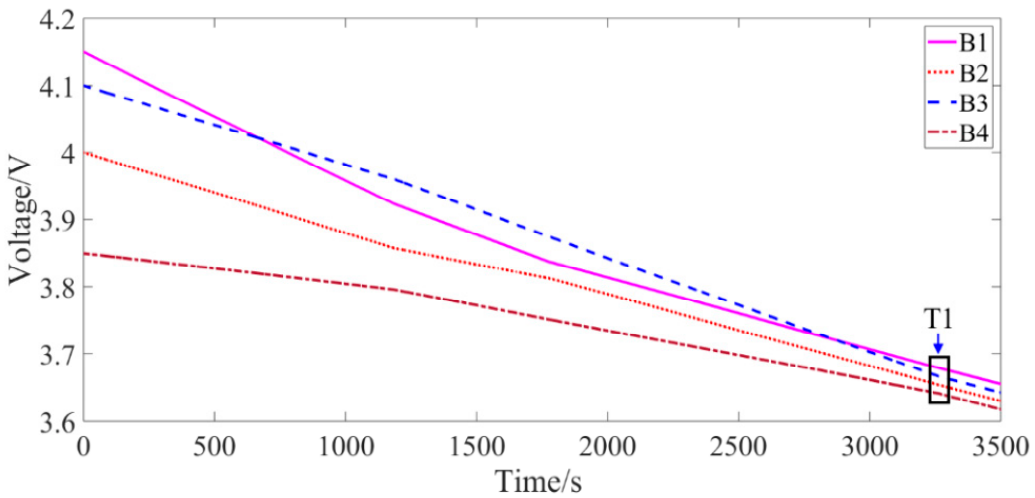
Figure 12. Discharging state simulation results.